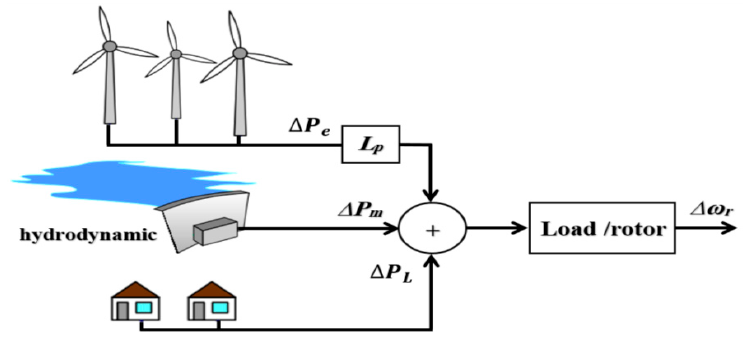
Figure 4. Wind turbines connected to hydro dominant power system.